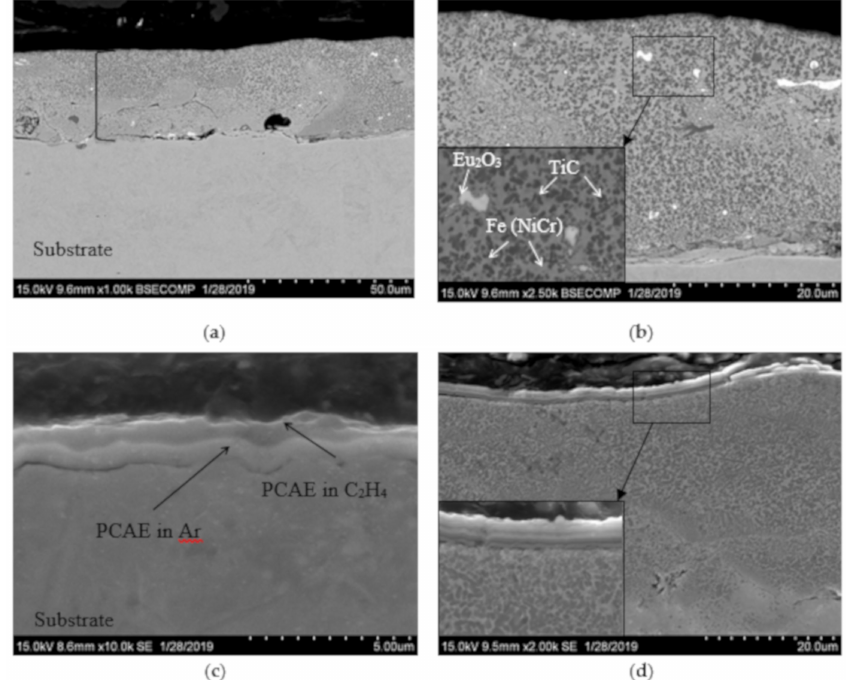
Figure 3. SEM cross-section images of the VESA ( a , b ), PCAE in Ar and C 2 H 4 ( c ), and VESA–PCAE ( d )